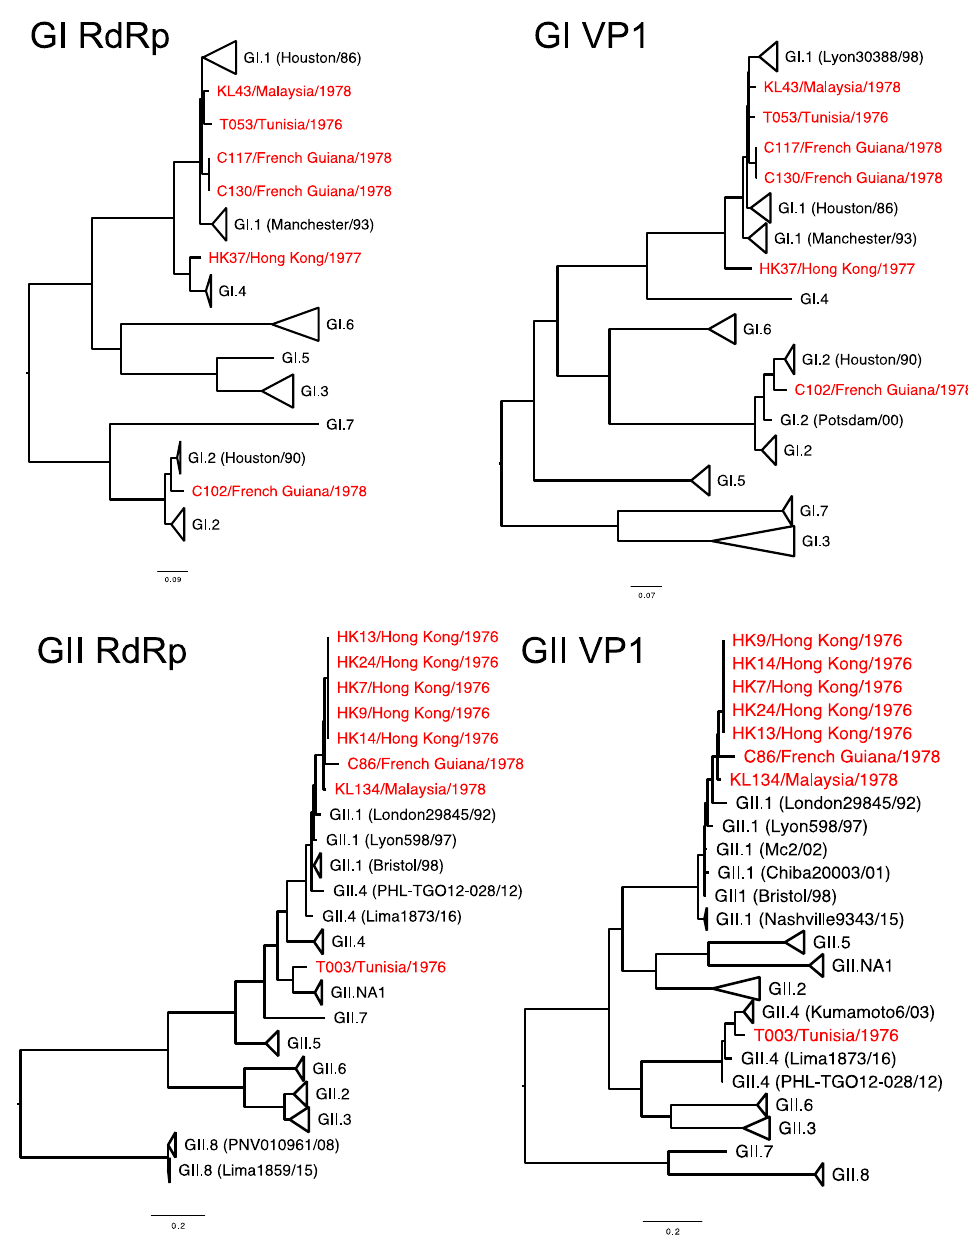
Figure 2. Phylogenetic tree of sapovirus GI and GII strains, circulating since 1976. The maximum likelihood phylogenetic trees were constructed using Kimura-2 parameter model with bootstrap values of ≥ 70. Samples analyzed in this study are highlighted in red. Sequences for partial RdRp (viral polymerase, > 650 nucleotide length) and nearly full-length VP1 ( ≥ 1575 nucleotide length) were separately analyzed for genotyping and detection of possible recombinants. To gain insight into the mechanisms of sapovirus evolution, we mined all full-length (or nearly full-length) capsid (VP1), partial viral RNA-dependent RNA polymerase (RdRp), and full-length (or nearly full-length) genomes of sapoviruses available in the public repositories. We were able to retrieve over 237 sequences from unique human sapoviruses, 125 corresponding to full-length (or